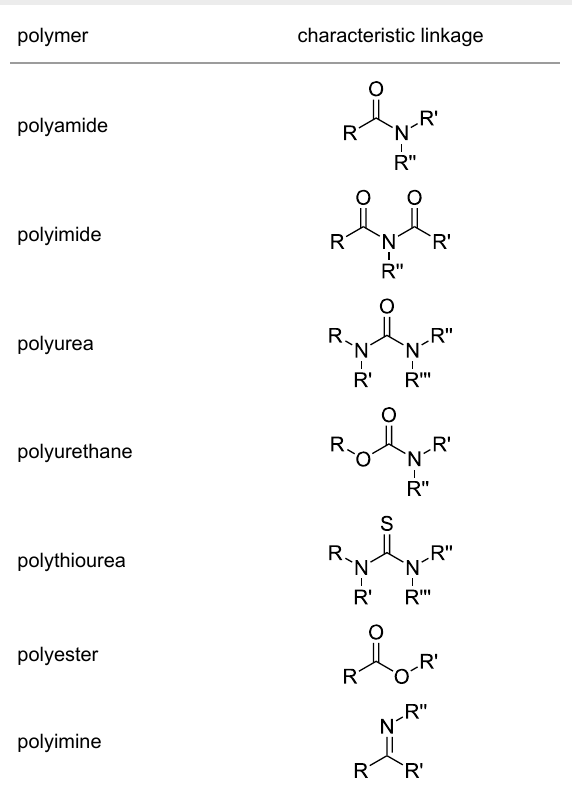
Table 2: Characteristic linkages for the polymer types deposited using